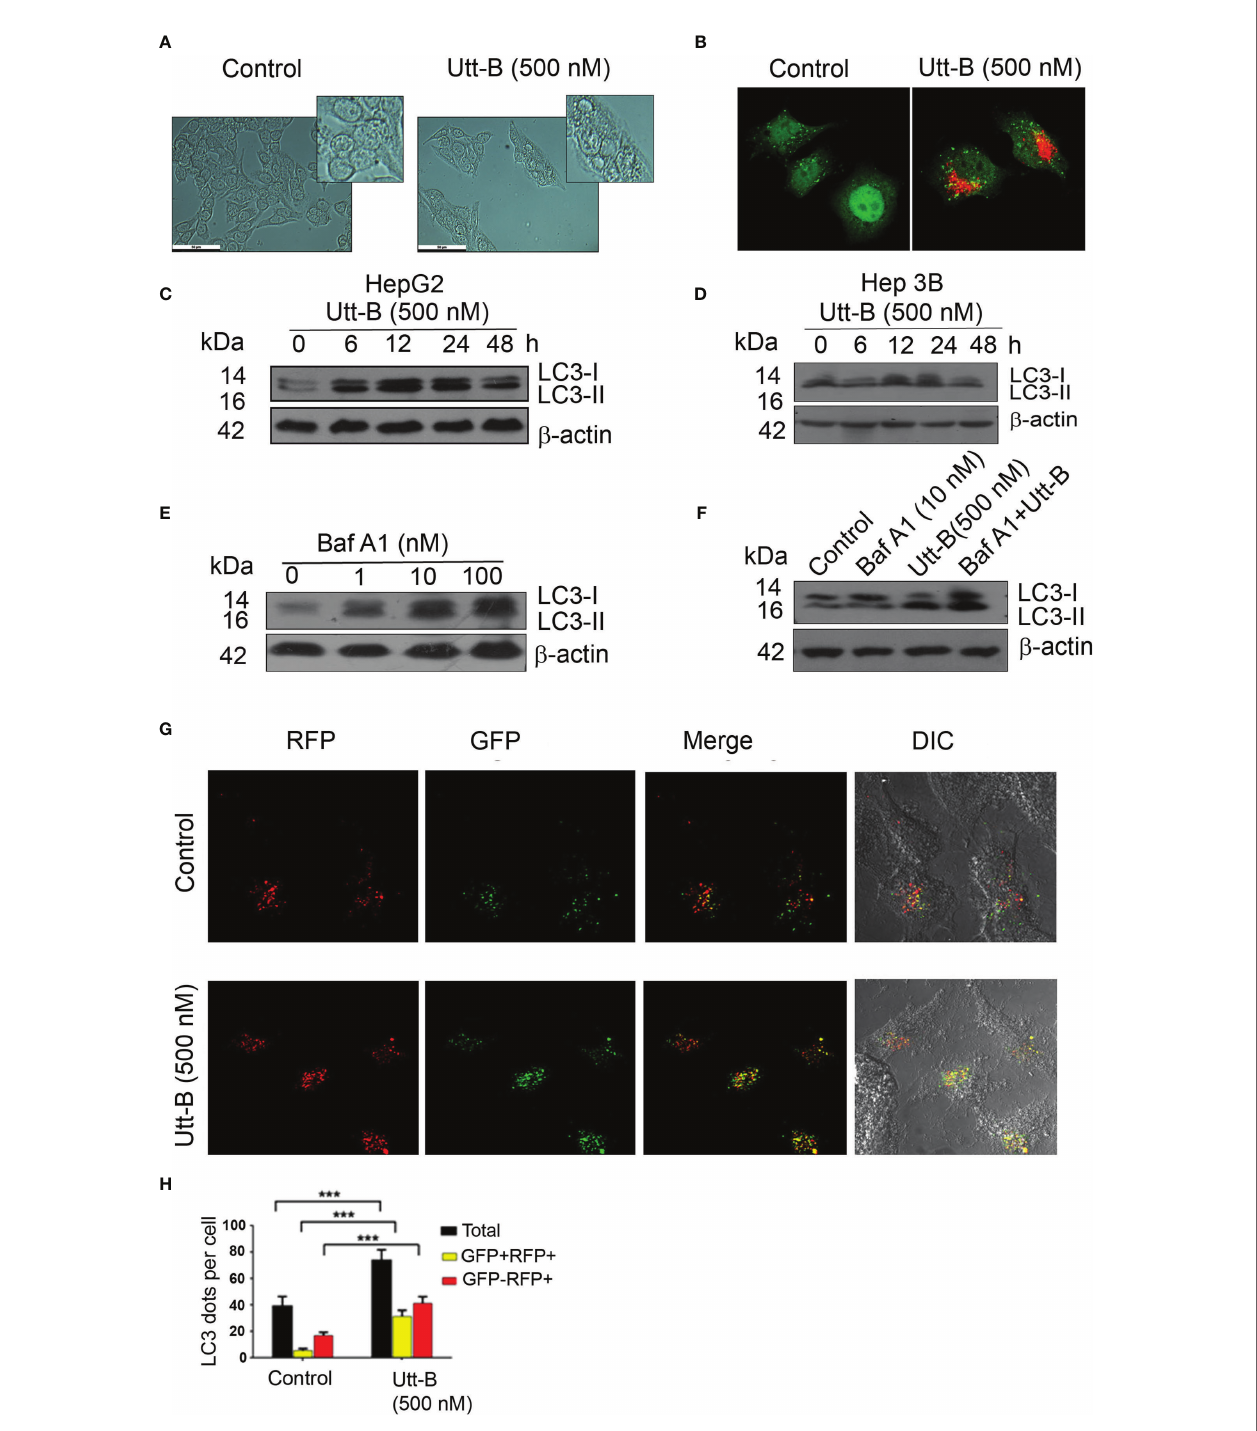
FIGURE 1 | Utt-B induces autophagy , in vitro . (A) Utt-B treatment induces the formation of vacuolated structures in HepG2 cells. (B) Acidic vacuoles are stained with Acridine Orange (C) Western blot results indicate that LC3II expression is induced in HepG2 cells from 6h to 12h in HepG2 cells. (D) Western blot results indicate that LC3II expression is induced in HepG2 cells from 12h to 24h in Hep3B cells. (E) 10 nM Baf A1 is enough to block autophagy in HepG2 cells, as inferred from LC3-II accumulation. (F) Co-treatment of Utt-B and Baf A1 increases LC3-II accumulation. (G, H) Accumulation of LC3-II by Utt-B was quantitated by RFP- GFP-LC3 tagged protein assay. *** level of signi fi cance